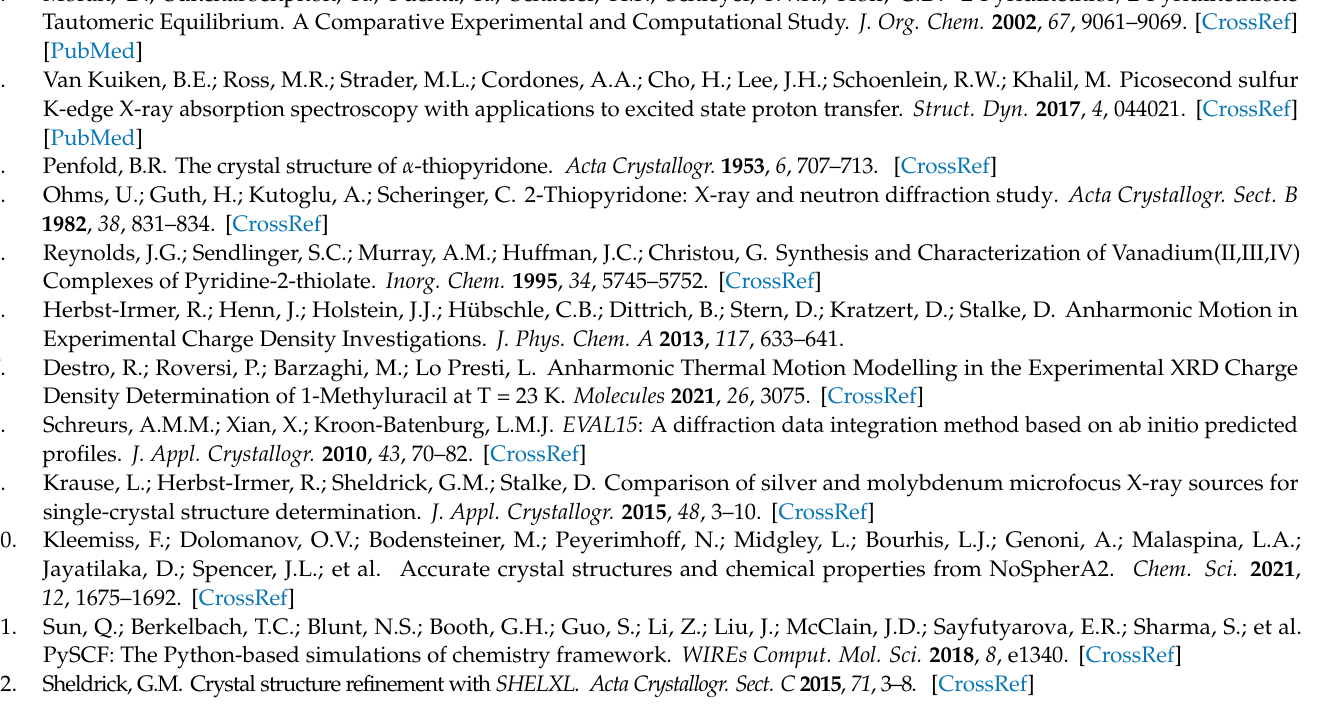
TLS analysis; Figure S3: Temperature dependence of the T-tensor from a rigid-body TLS analysis; Figure S4: Difference electron density (independent atom model); Figure S5: Fractal dimension plot (independent atom model); Figure S6: Fractal dimension plot (NoSpherA2); Figure S7: Comparison of calculated structure factors (isotropic/anisotropic hydrogen atoms); Figure S8: Peanut plot (No- SpherA2); Figure S9: Residual density after multipole refinement (anisotropic atoms); Figure S10: Peanut plot (multipole model); Figure S11: Residual density after the final multipole refinement; Figure S12: Fractal dimension plot after the final multipole refinement; Table S1: Temperature- dependent unit cell determinations; Table S2: Temperature dependence of the N–H · · · S hydrogen bond; Table S3: Temperature dependence of the intermolecular π · · · π stacking interaction; Table S4: Kitajgorodskij packing index (K.P.I.); Table S5: Void calculation with CrystalExplorer; Table S6: Com- parison of NoSpherA2 refinements with isotropic and anisotropic displacement parameters; Table S7: Analysis of variance of Table S6; Table S8: Analysis of variance for the multipole refinement; Table S9: Temperature dependence of the intermolecular C–H · · · S